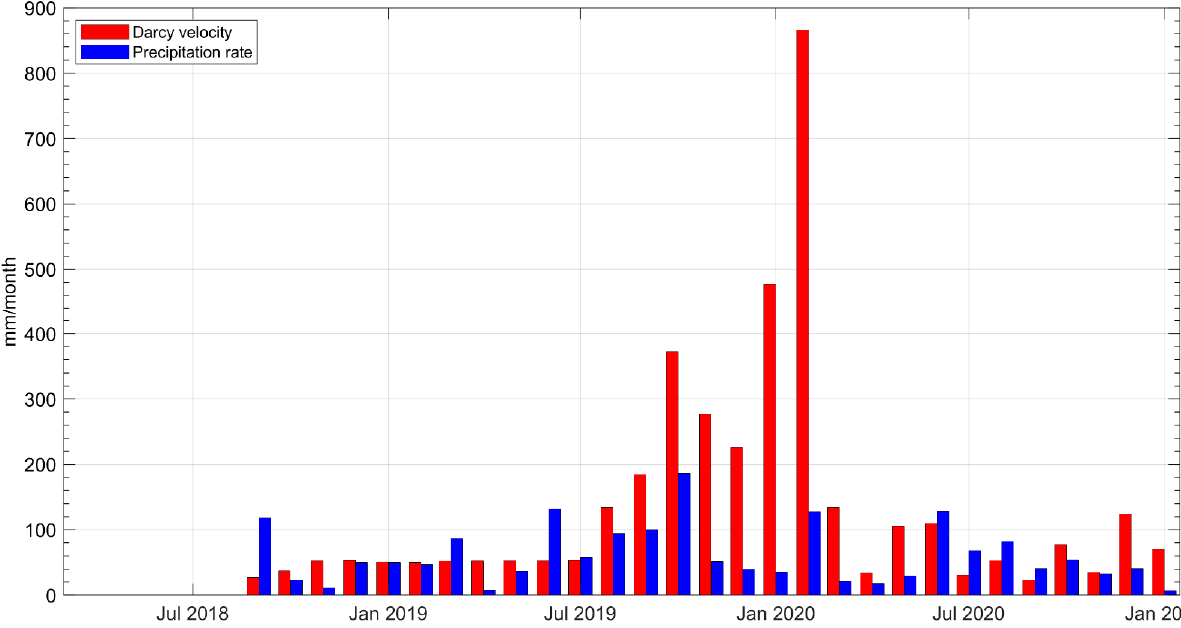
Figure 9. Monthly measured precipitation and estimated Darcy velocity from flow meter measure- ments.